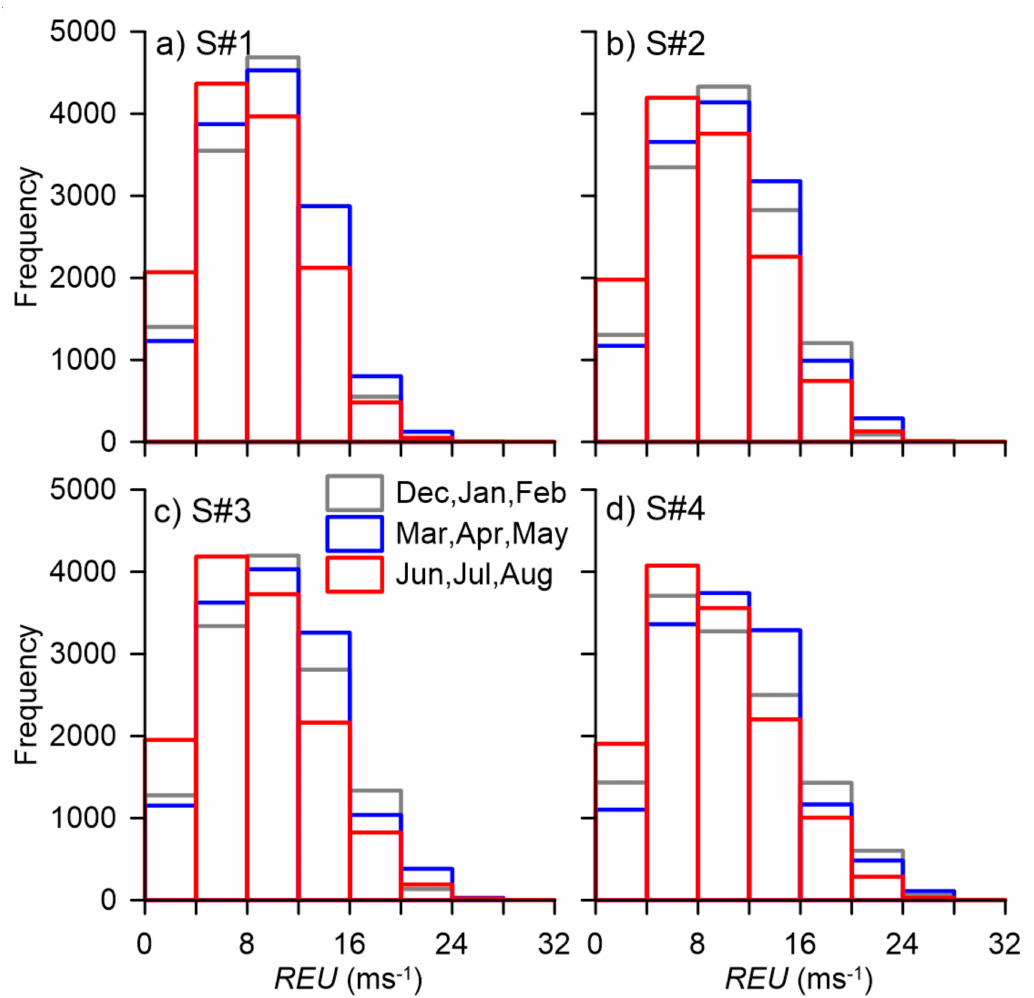
Figure 6. Histograms of 10-min REU discretized in 4 ms − 1 wind speed classes as sampled by climatological season (colors) and the four WT scenarios (panels ( a – d )). The REU shown are for the most westerly location Site 1 (43 ◦ N, 95 ◦